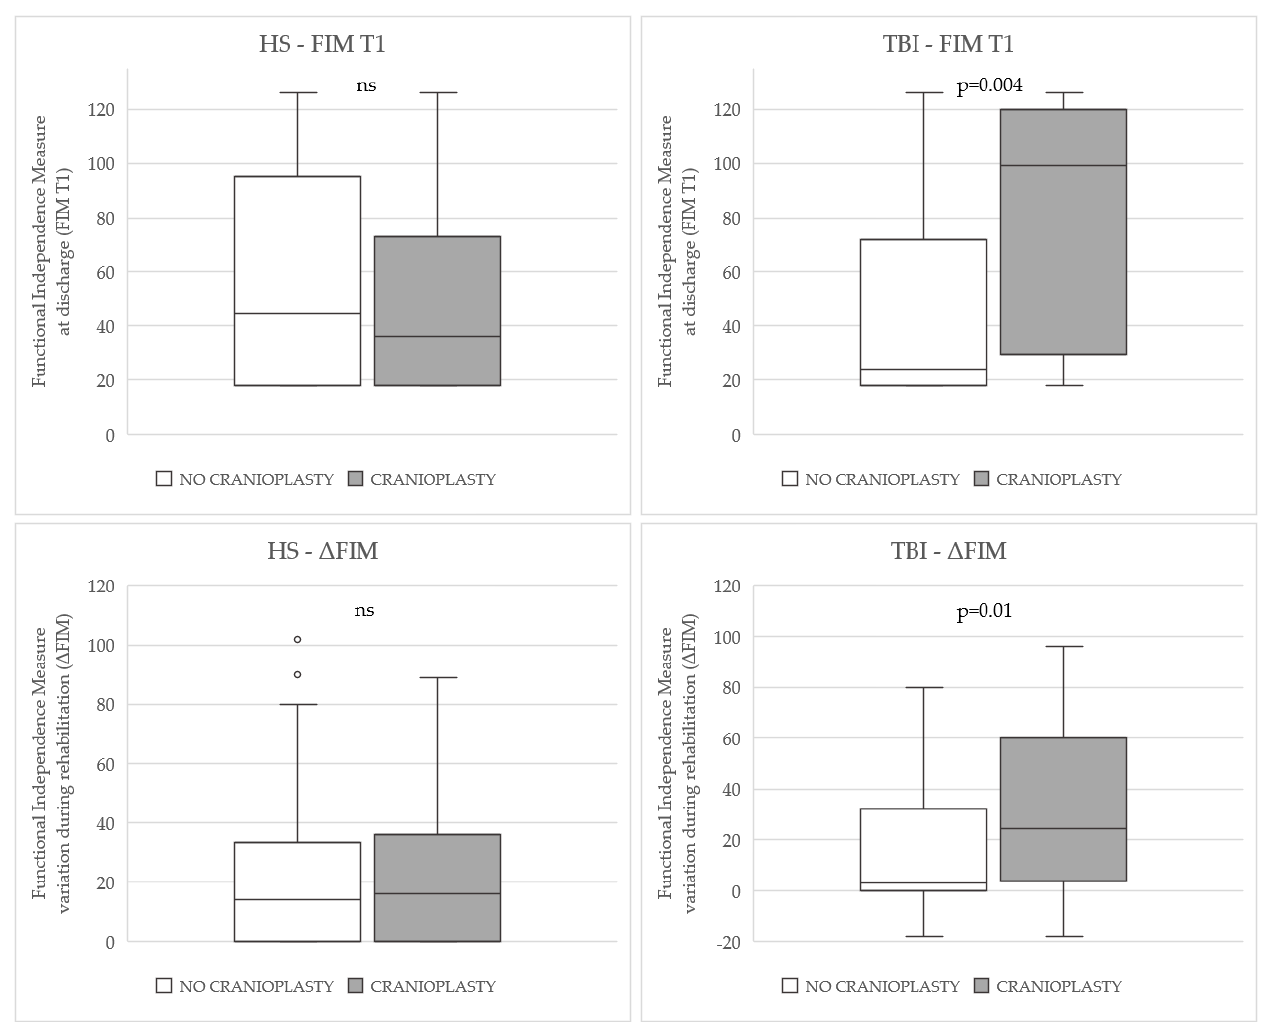
Figure 1. Tukey’s box-and-whisker plot of FIM T1 (upper boxes) and Δ FIM (lower boxes) in patients who underwent cranioplasty and those who did not, according to the type of brain injury (HS or TBI). Outliers are plotted as individual points. Abbreviation: ns, non-significant.